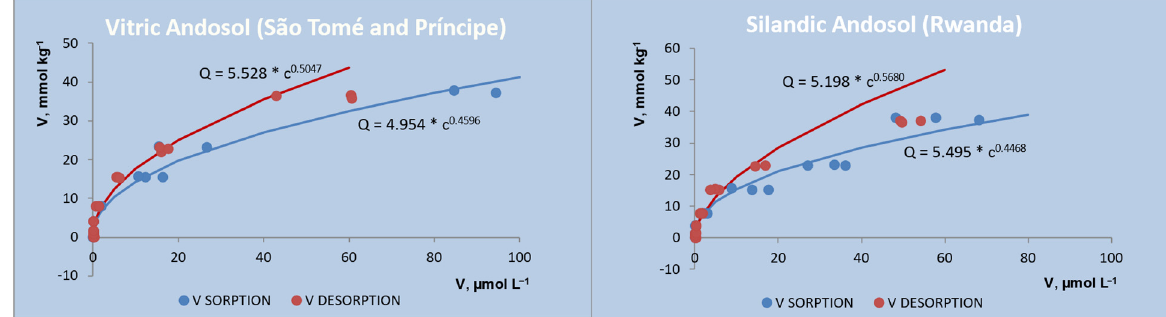
Figure 3. V sorption and desorption isotherms (sorbed V (mmol kg − 1 ) vs. V concentration in the equilibrium solution (µmol L − 1 )) fitted to the Freundlich model.